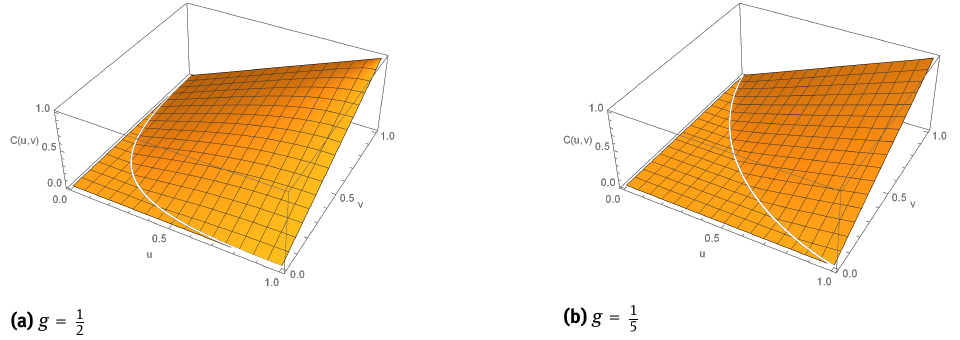
Figure 6: Surfaces of a shifted exponential Lorenz copula for different values of g